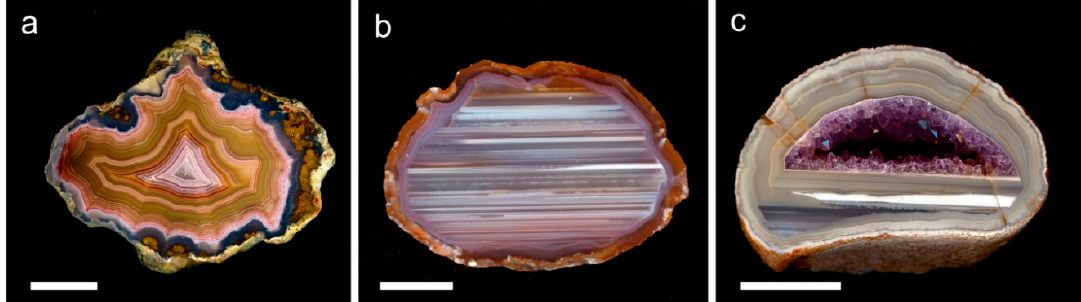
Figure 7. Examples for different types of banding in agates; ( a ) wall ‐ lining (“fortification”) agate from Ojo Laguna (Chihuahua, Mexico); ( b ) horizontal banding (“Uruguay agate”) in an agate from Bightbridge, Simbabwe; ( c ) mixed type with both wall ‐ lining and horizontal banding as well as macrocrystalline amethyst in the center from Tres Pinheiros ‐ Fontoura Xavier (Rio Grande do Sul, Brazil); Scale bar is 2 cm.